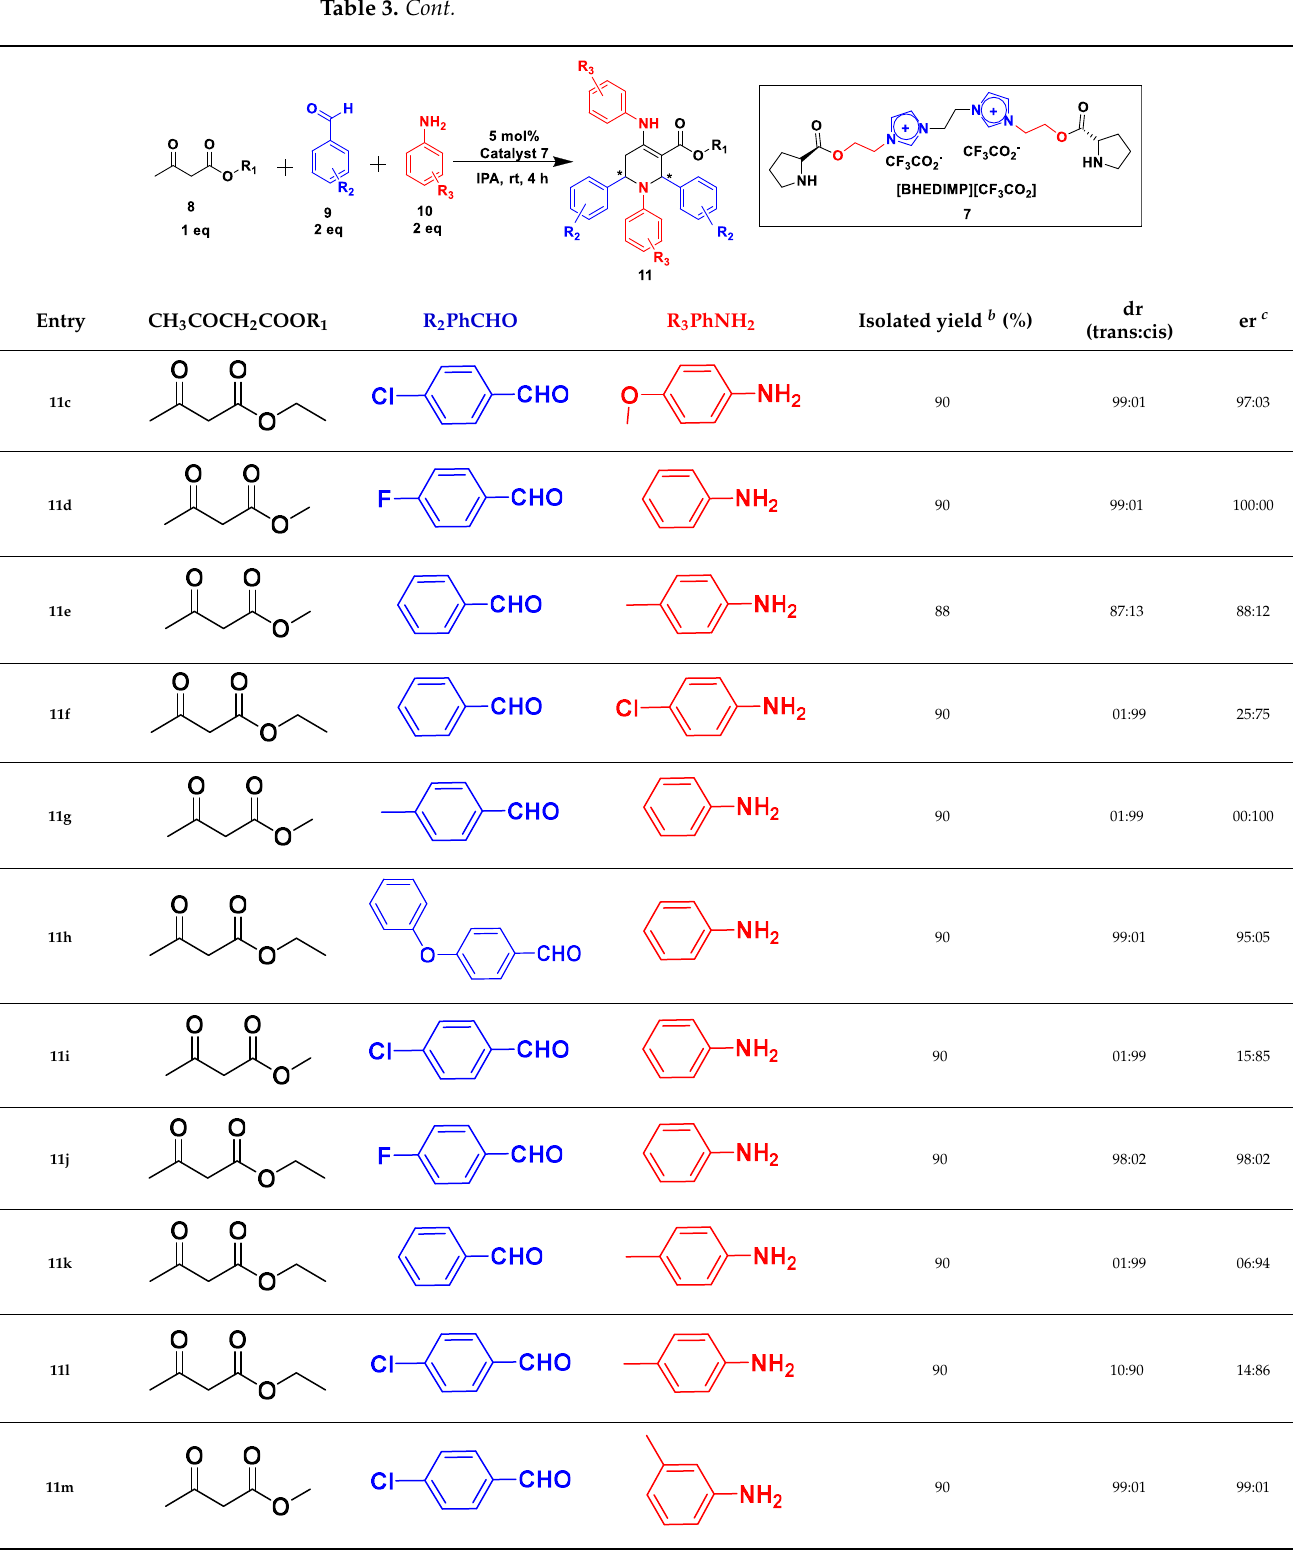
Table 3. Cont. Table 3. Substrate scope for several THP derivatives 11a – o a